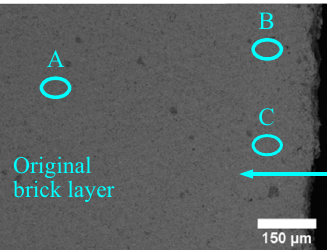
Figure 6: SEM picture ofcross section at1/2 height ofAl 2 O 3 refractory.